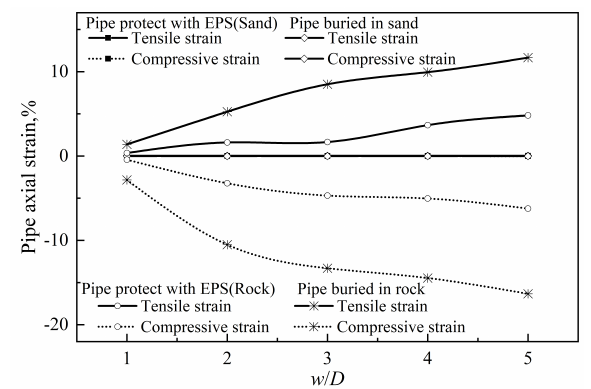
Fig. 12. Axial strain of buried pipe with different EPS